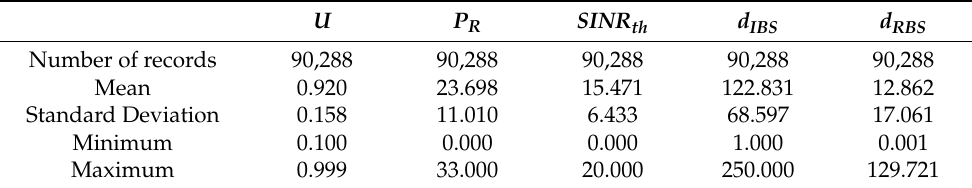
Table 3. The statistical description of the dataset.